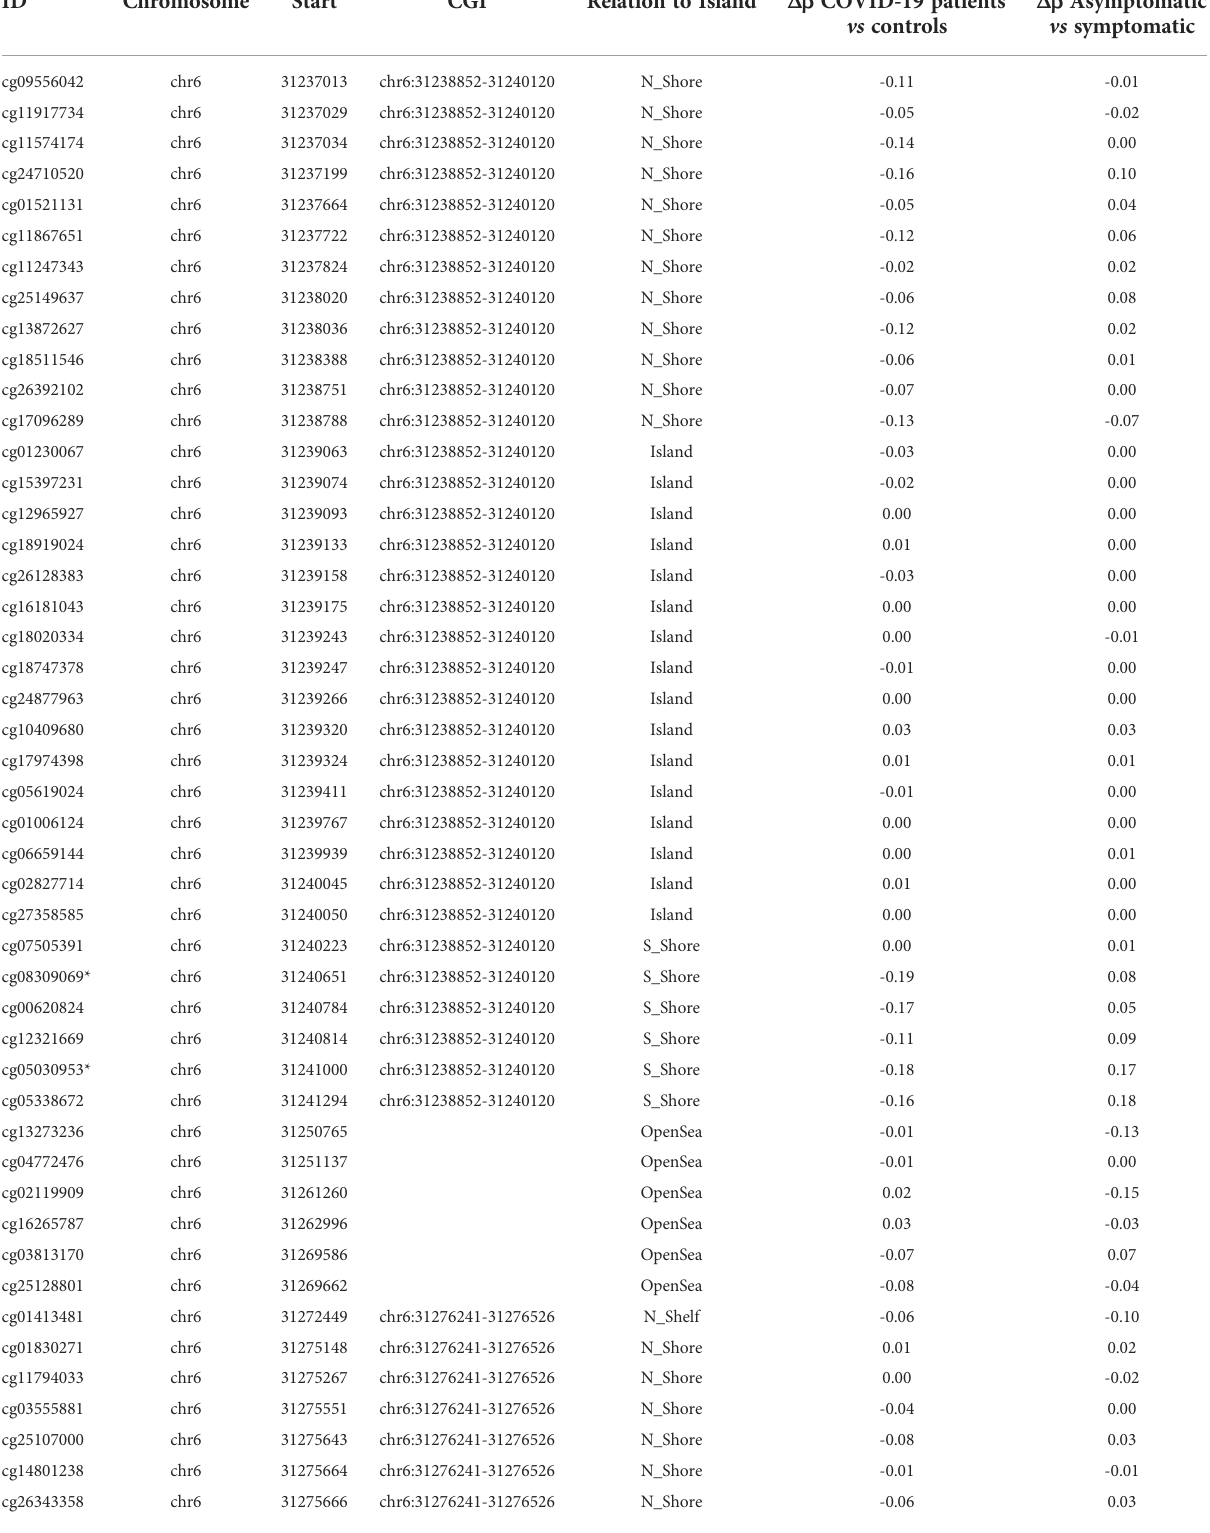
TABLE 2 DNA methylation analysis in CpG sites associated with HLA-C gene in COVID-19 patients vs controls and asymptomatic vs symptomatic COVID-19